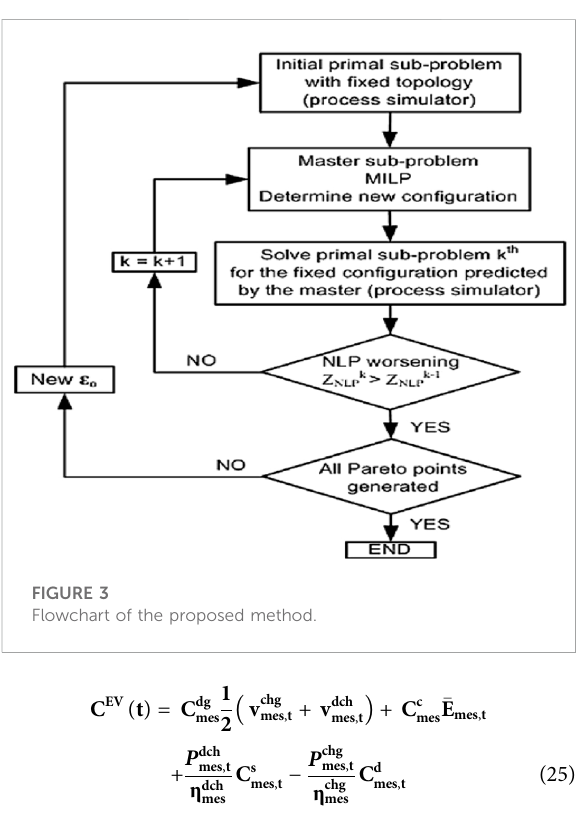
TABLE 2 Price of